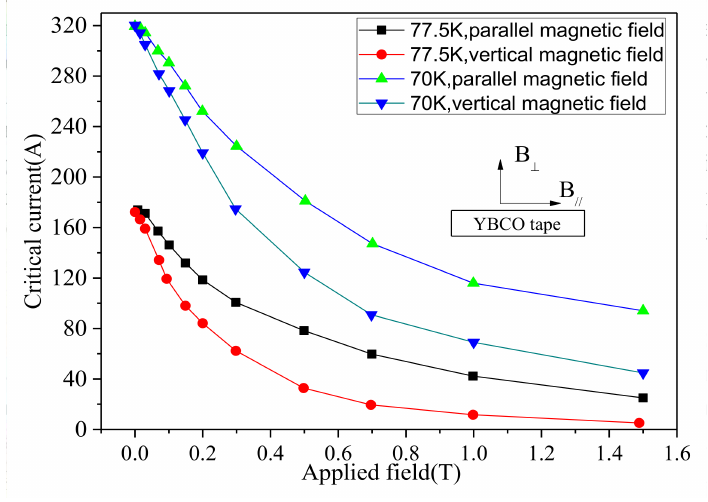
Figure 2. Dependence of YBCO critical current on the operating temperature and the applied field.